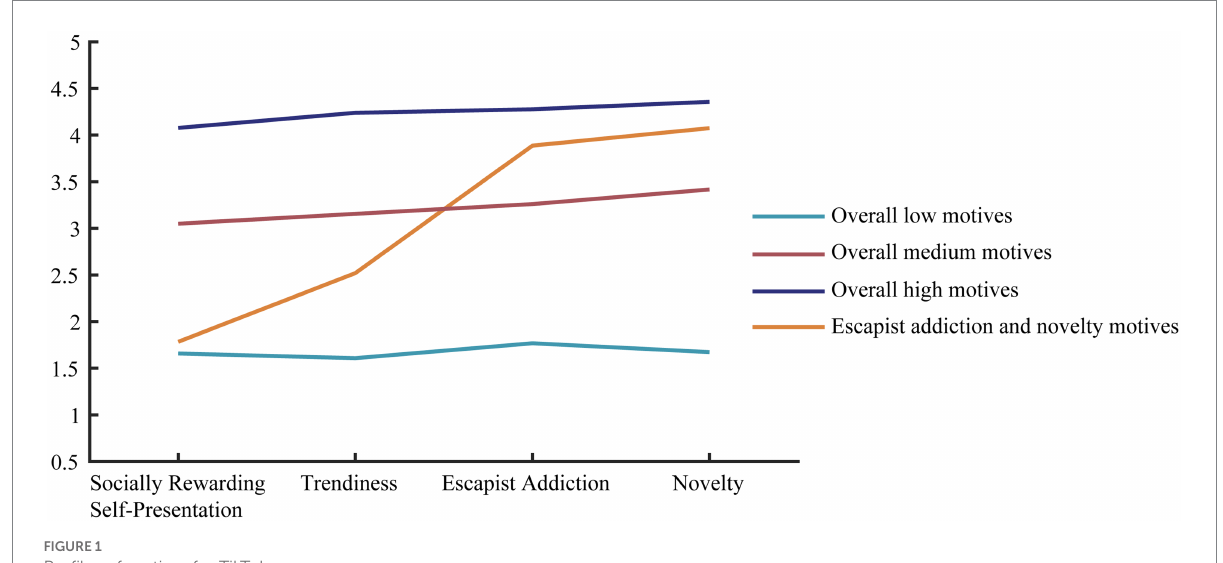
FIGURE 1 Profiles of motives for TikTok use.